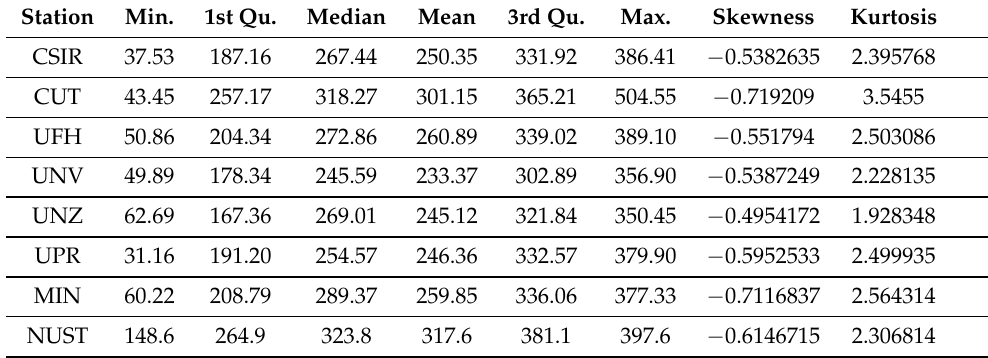
Table 4. Summary statistics of GHI for the eight